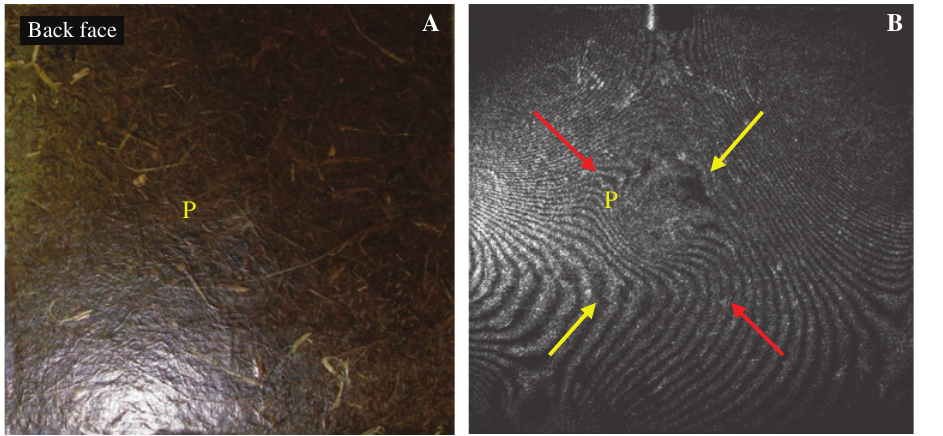
Figure 2 (A) Photo of the sample (back face), (B) DE result of the sample: the red arrows indicate the delaminations due to the indentation test detected by HI, the yellow arrows show the compressed zone, while P the indented